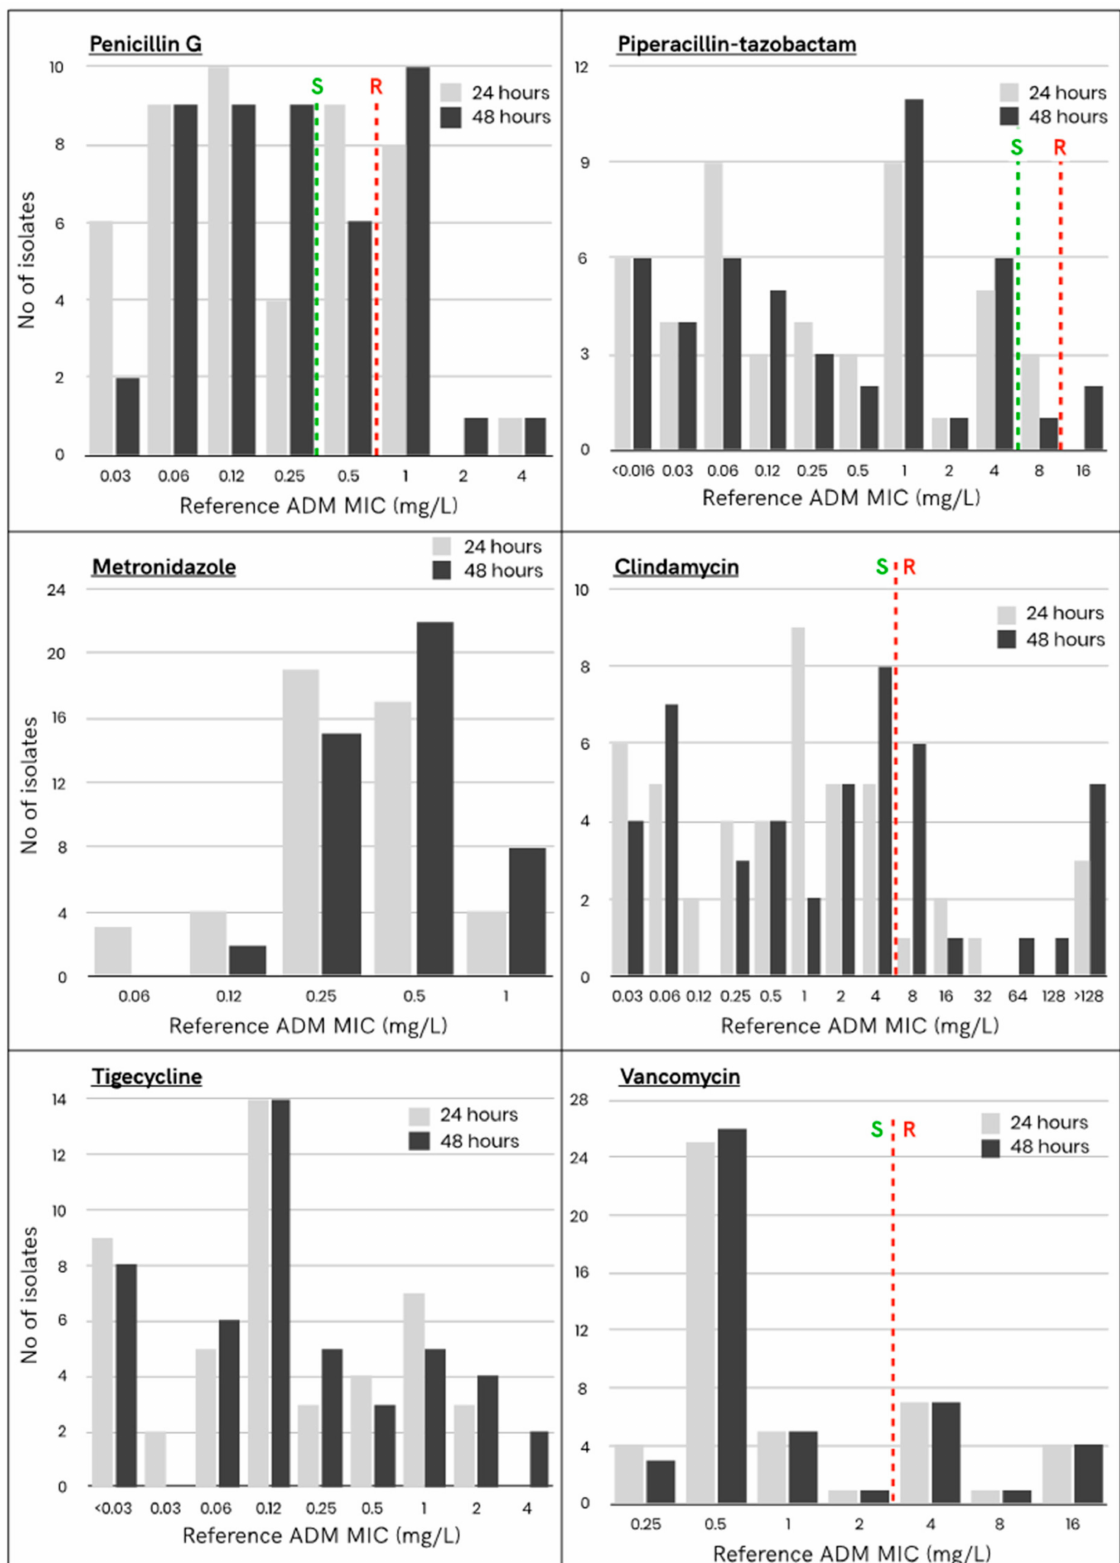
Figure 1. MICs distribution obtained at 24 and 48 h by the reference agar dilution method among the tested isolates and the EUCAST clinical breakpoints. The x -axis represents the MIC and the y -axis represents the number of strains with a given MIC. S: Susceptible, R: